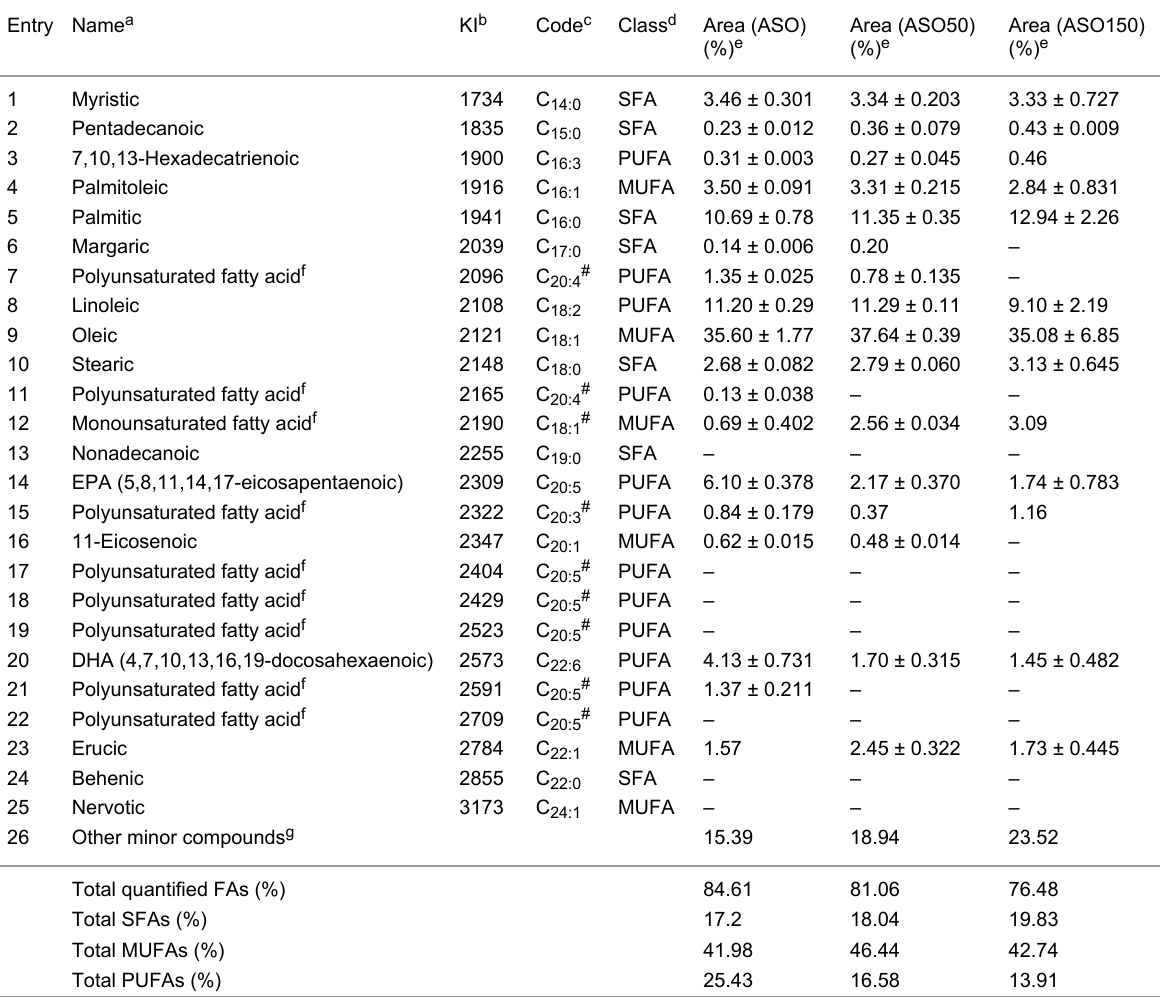
Table 1: Relative concentrations of FAs (as methyl esters) obtained from the GC–MS analysis of the derivatized, raw, Atlantic salmon oil (ASO) and those degraded at low (50 °C, code ASO50) and high (150 °C, code ASO150)